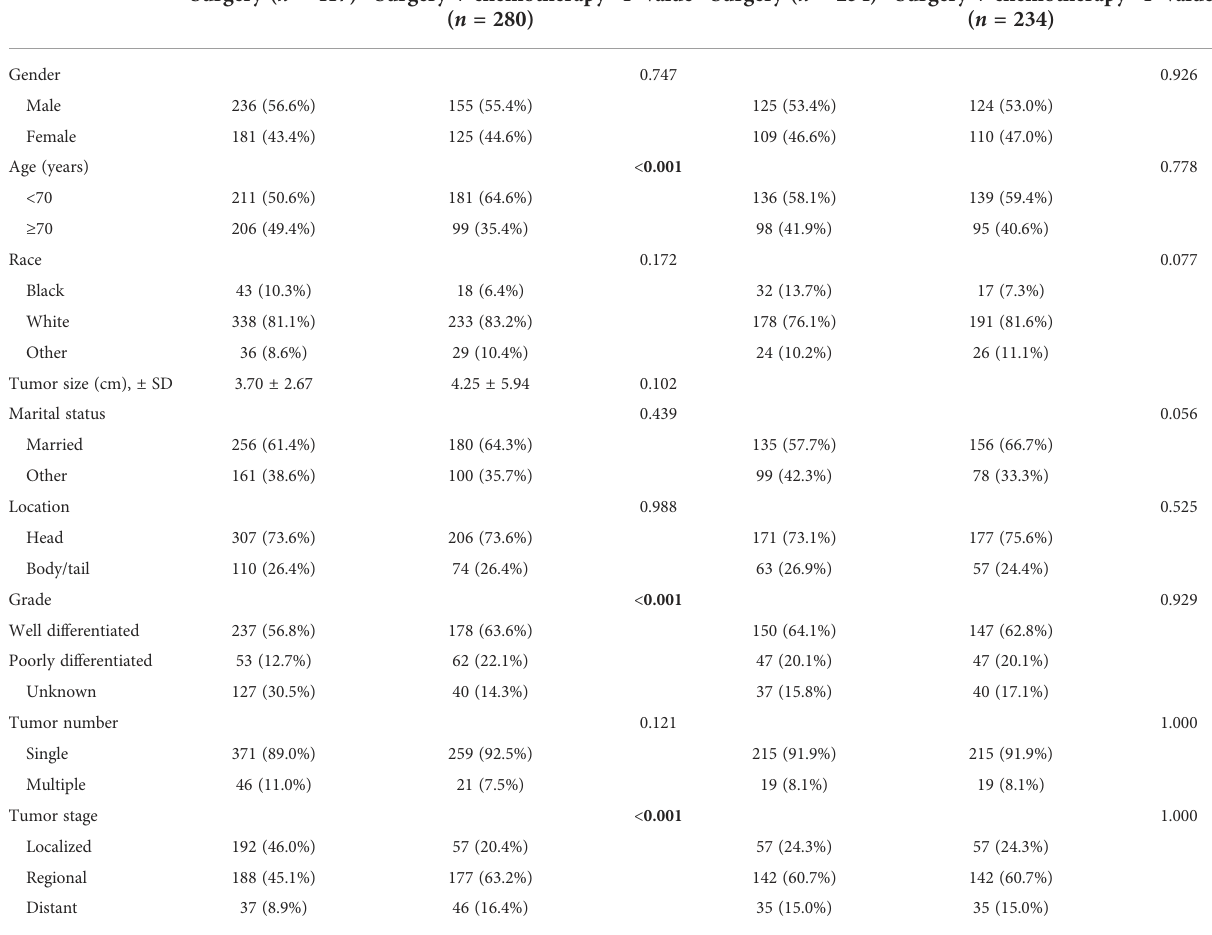
TABLE 6 Demographic and clinical characteristics of IPMN patients undergoing surgery or surgery plus chemotherapy before and after